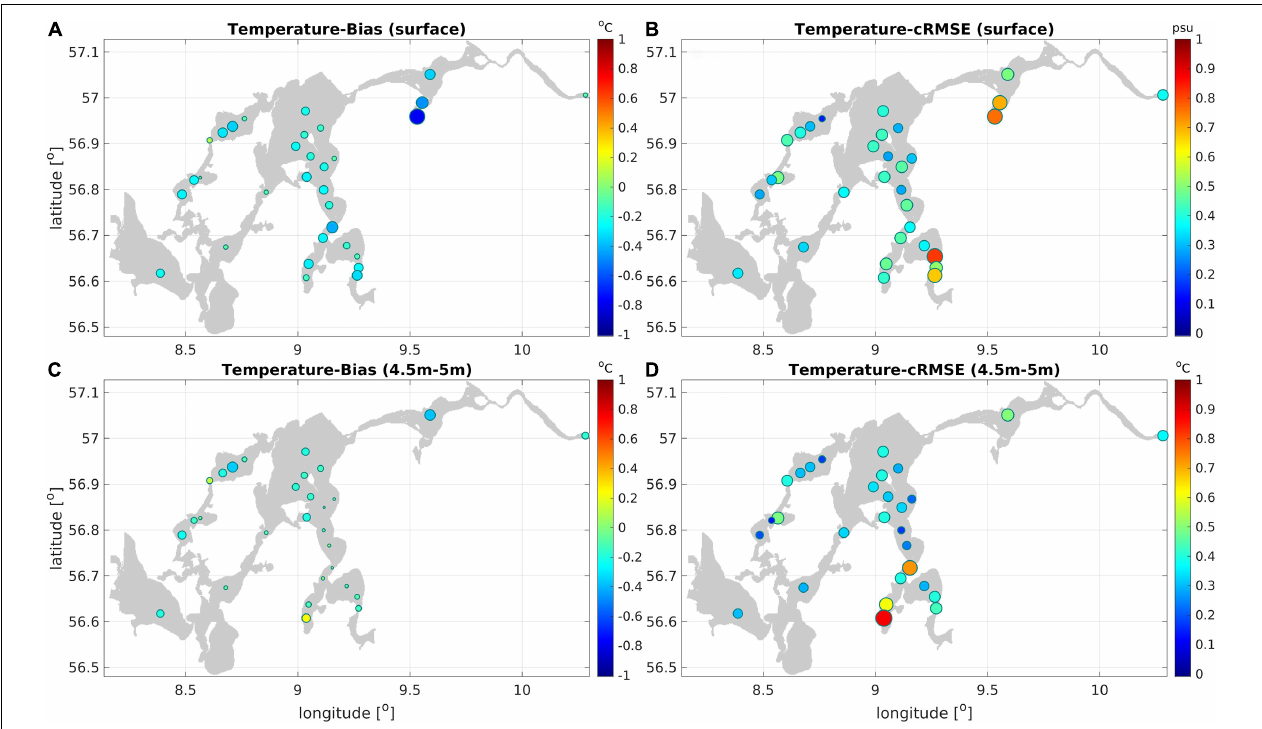
FIGURE 6 | Bias (A,C) and cRMSE (B,D) of modeled water temperature at the surface (upper panel, A,B ) and 4.5–5 m depth (lower panel, C,D ) in the Limfjord. Each marker represents a station with at least 10